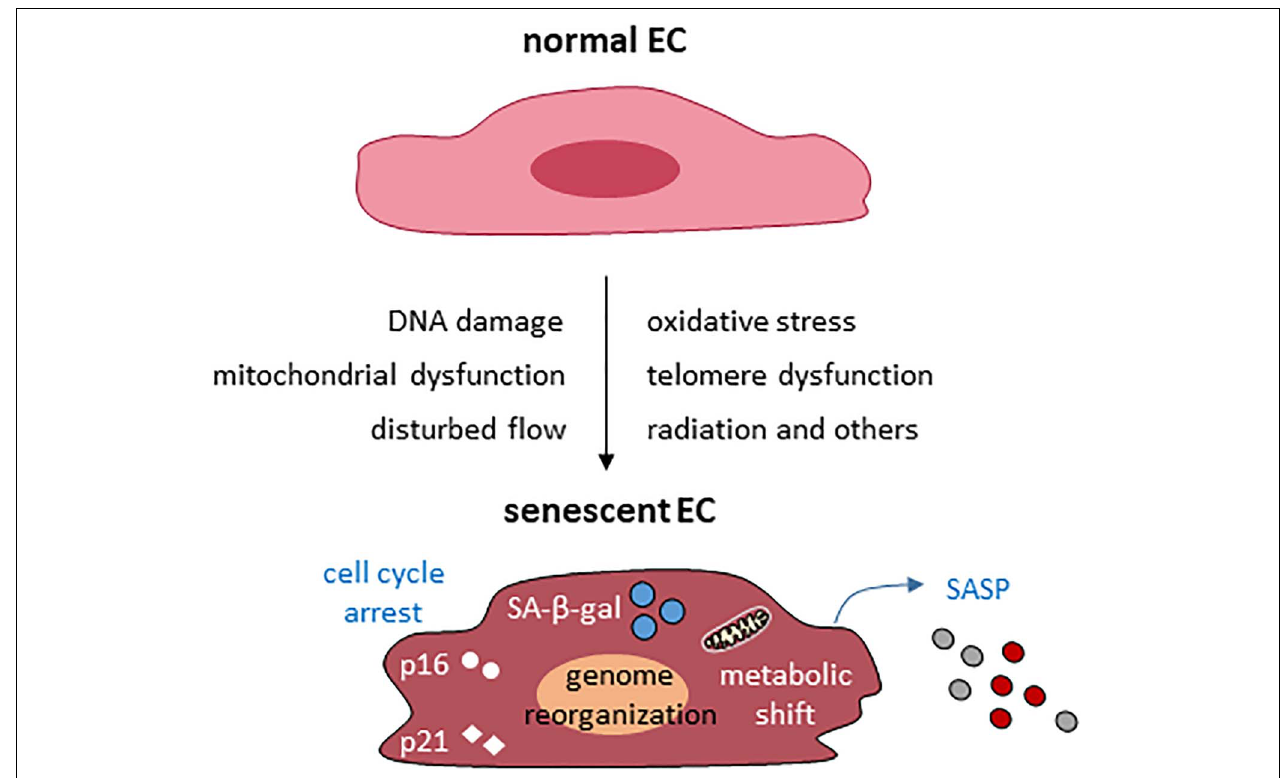
FIGURE 1 | Common causes and features of endothelial cellular senescence. EC, endothelial